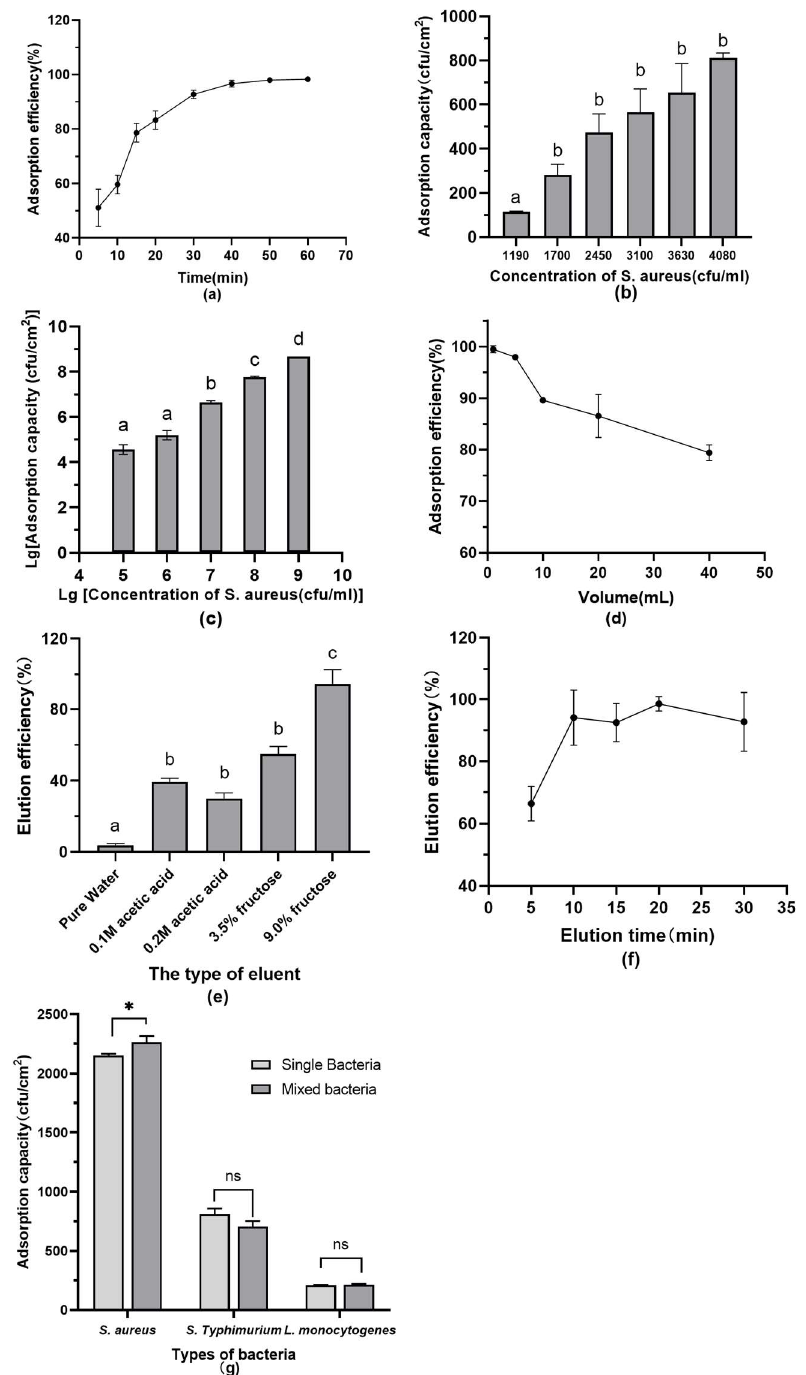
Figure 5. Effect of enrichment time ( a ), low bacterial concentration ( b ), high bacterial concentration ( c ), volume ( d ), eluent type ( e ), elution time ( f ), and mixed bacteria ( g ) on the adsorption efficiency or capacity of S. aureus by paper@epoxy@PEI-DFFPBA. Absorption capacity without bacteria is 0. Bars show the means and the error bars show standard deviations. The results of ANOVA analysis showed significant differences in Figure 5b,c,e. Asterisks indicate significant difference levels; * p < 0.05, ns p > 0.05. The a, b, c, d in the figure indicate significant differences between multiple groups. At the S. aureus concentration of 2 × 10 9 CFU/mL, the absorption capability reached 1.87 × 10 8 CFU/cm 2 (2.40 × 10 7 CFU/mg), approximately 2.6~112 times that of other